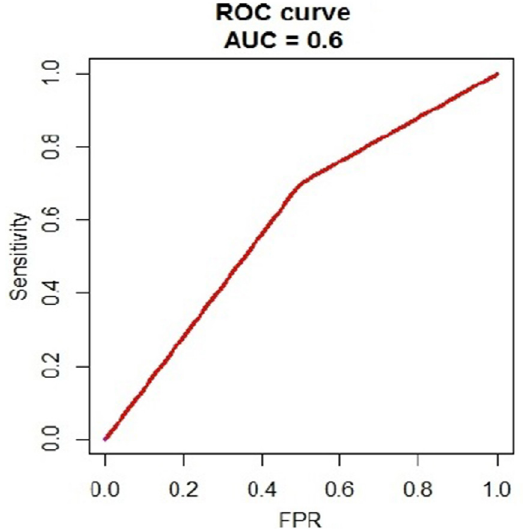
Fig. 4. ROC curves of the proposed method before applying the gene selection process for sample size of 10.